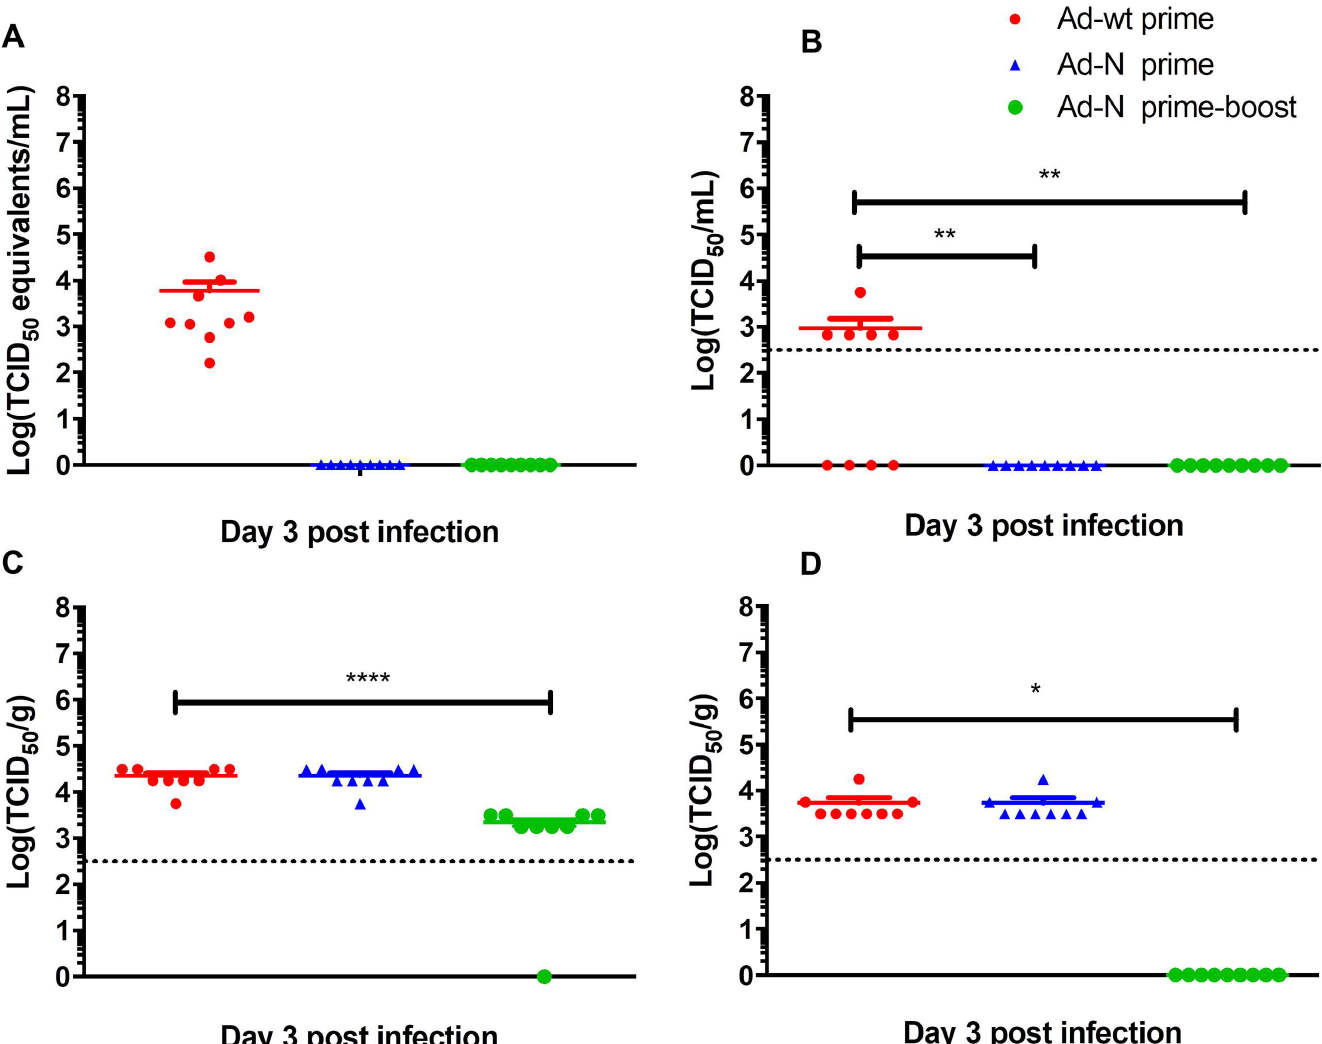
Fig 2. CCHFV loads in single-dose and prime-boost vaccinated and challenged mice. Groups of IFNAR -/- mice were either single-dose (1.25 × 10 7 IFU; intramuscular) or prime-boost (1.25 × 10 7 IFU; intramuscular / 10 8 IFU; intranasal) vaccinated with Ad-N or Ad-wt and challenged with 1000 LD 50 of CCHFV 28 days following final vaccination. Mice (n = 9 per group) were anesthetized, bleed and euthanized to harvest organ samples on day 3 post CCHFV challenge. Viral loads were analyzed by quantitative RT-PCR or infectivity assay. (A) Viremia analyzed by quantitative RT-PCR; (B) Viremia analyzed by TCID 50 assay; (C) liver virus load analyzed by TCID 50 assay; (D) spleen viral loads analyzed by TCID 50 assay. Data is shown as individual organ data points, the mean and the standard error of the mean. The dotted line illustrates the limit of detection of the TCID 50 assay. (cid:3) p < 0.05, (cid:3)(cid:3) p < 0.01, (cid:3)(cid:3)(cid:3)(cid:3) p < 0.0001.